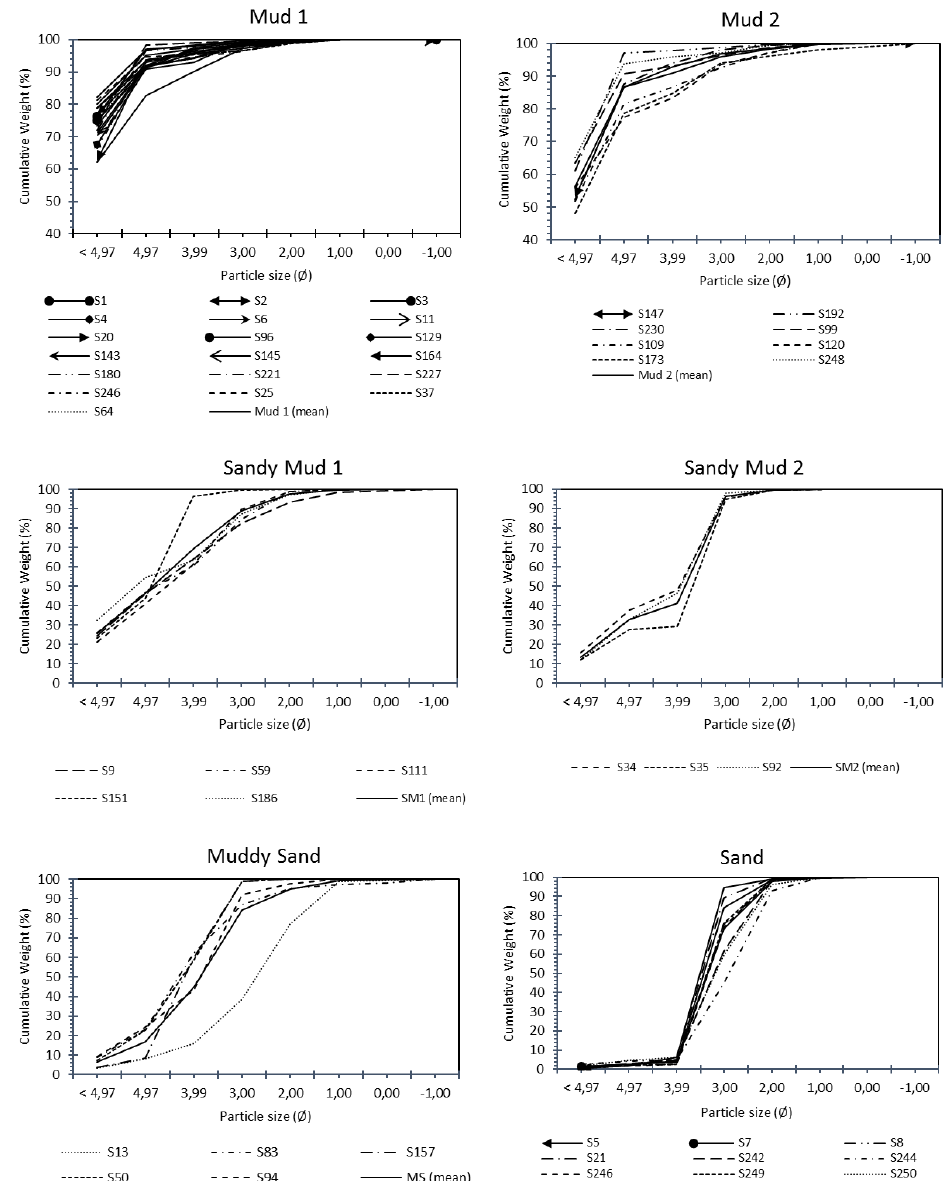
Figure 6. Cumulative frequency curves of the facies muddy sand, sand and the sub-facies of mud (Mud1 and Mud2) and sandy mud (SM1 and SM2). (Mud1 and Mud2) and sandy mud (SM1 and